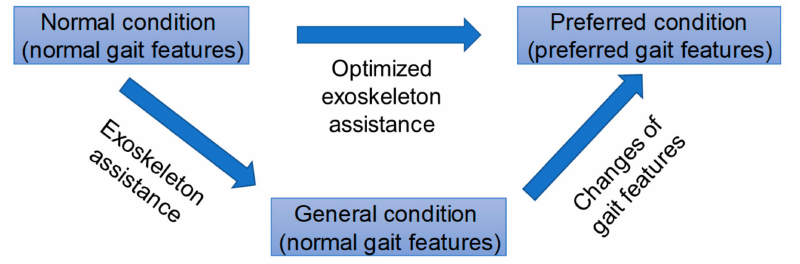
Figure 1. Schematic diagram of assisted walking when considering the changes of the gait